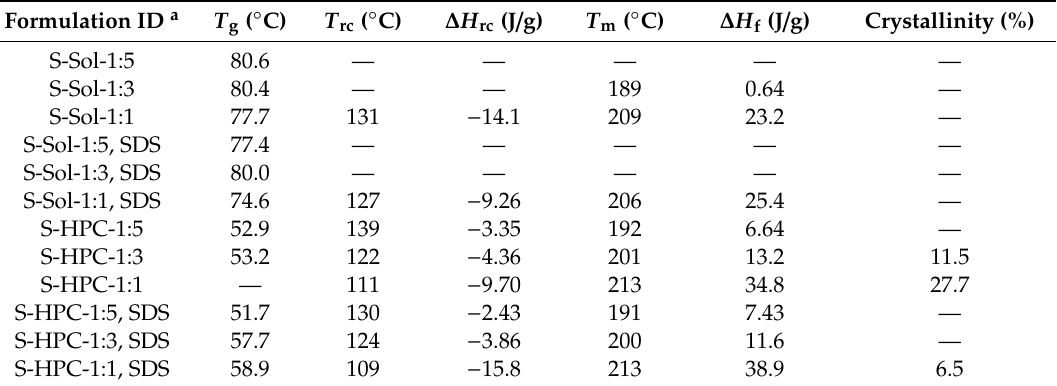
Table 4. Temperature–enthalpy values of various thermal events observed in the DSC traces and crystallinity estimated from the XRPD di ff